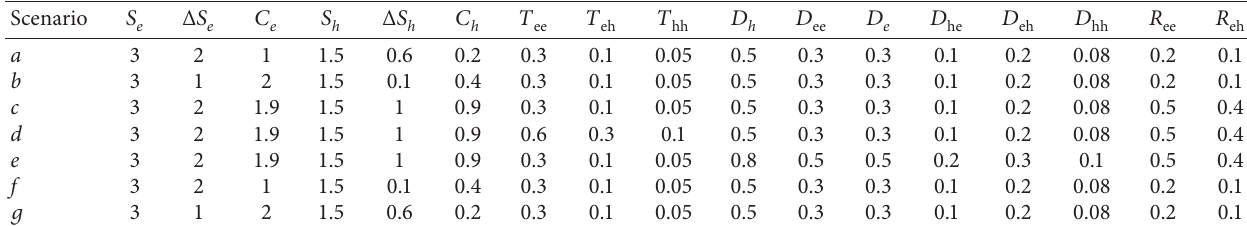
Table 7: Simulation parameter setting in different scenarios under market mechanism.